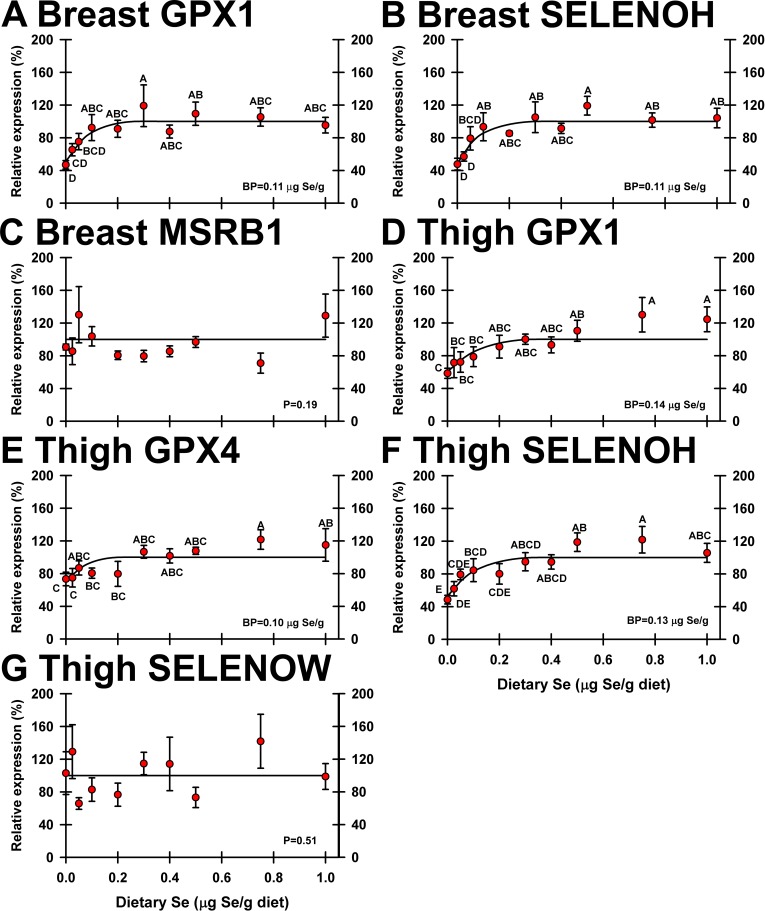
Effect of dietary Se on significantly-regulated selenoprotein transcripts in turkey breast and thigh muscle.Plotted are relative transcript levels for breast GPX1 (A), breast SELENOH (B), breast MSRB1 (C), thigh GPX1 (D), thigh GPX4 (E), thigh SELENOH (F), and thigh SELENOW1 (G) in poults supplemented with graded levels of dietary Se for 28 d. Values shown are means ± SEM (n = 5/treatment). Means without a common letter are significantly different (p<0.05). Overall levels of significance, as determined by ANOVA, are given in Table 1. Se response curve breakpoints (BP) are calculated as described in text. Breast MSRB1 and thigh SELENOW1 are examples of transcript expression not significantly regulated by dietary Se.